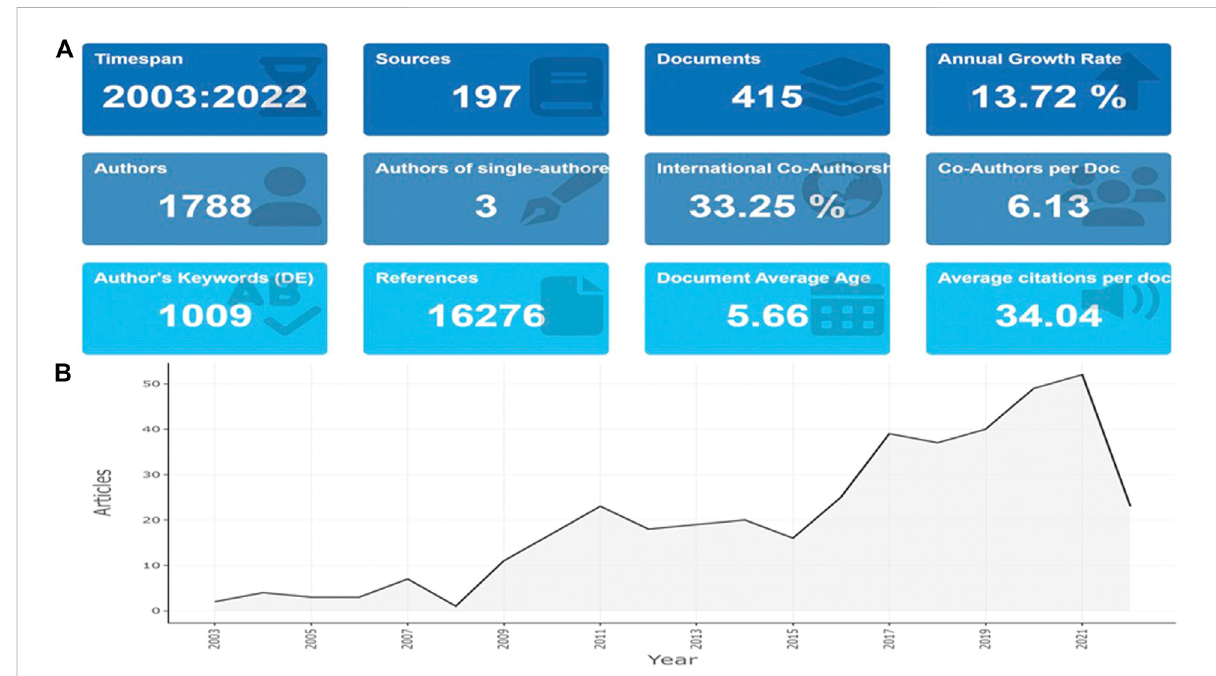
FIGURE 1 Main information (A) and annual scienti fi c production (B) of publications concerning applications of TPP in biomedical fi